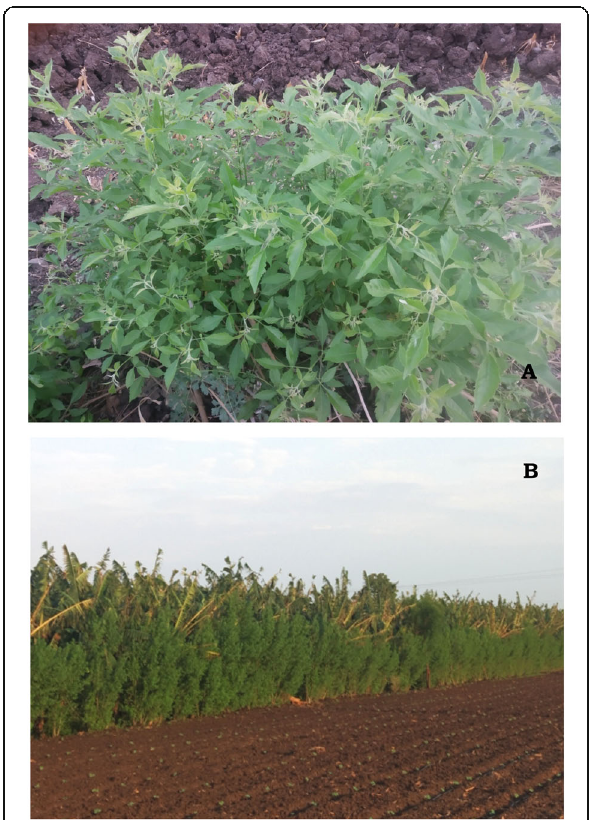
Fig. 1 a Vitex negundo plant. b Plantation of V. negundo at the boundary of banana